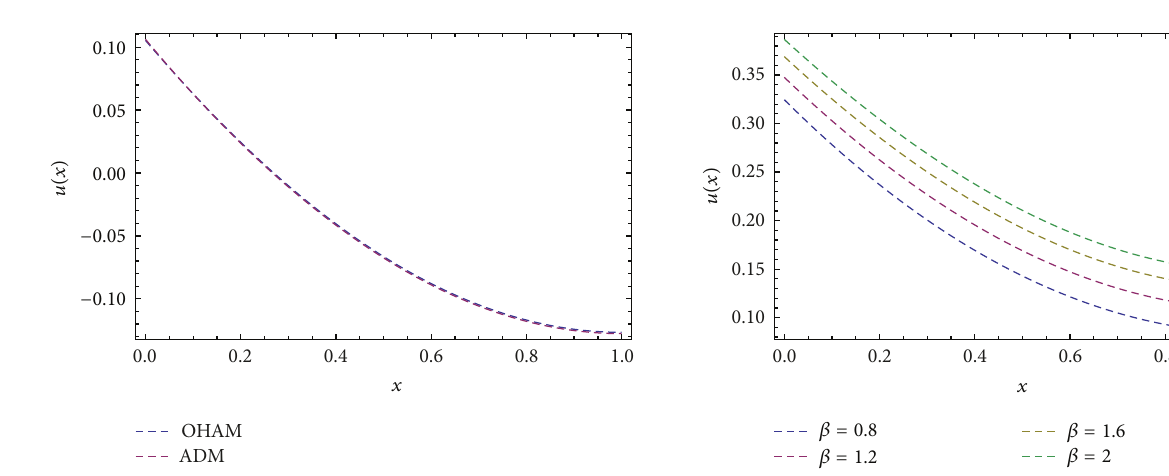
Figure3:ComparisonofADMandOHAMmethodsforliftvelocity profile is shown for the given parameters and auxiliary constants. 𝑚 = 0.5 , 𝑀 = 0.1 , 𝛽 = 0.3 , Λ = 0.01 , 𝛼 = 0.1 , 𝐶 and 𝐶 2 = −0.0208205048 .